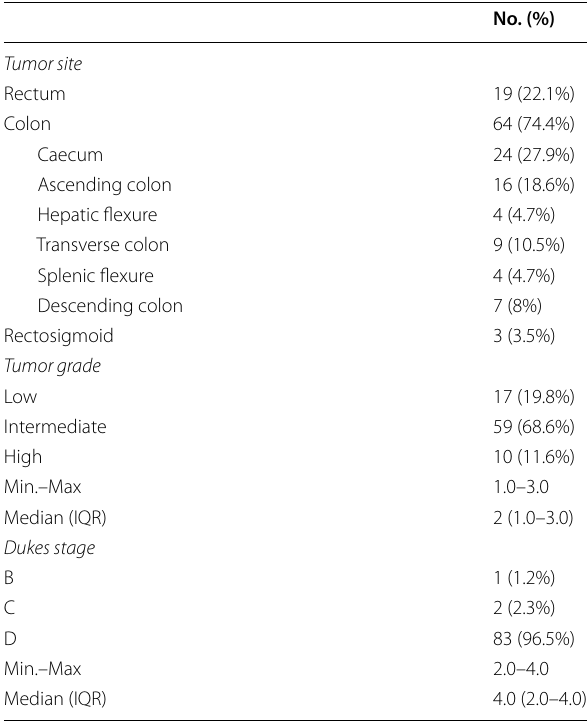
Table 1 Clinical characteristics of the study subjects ( n